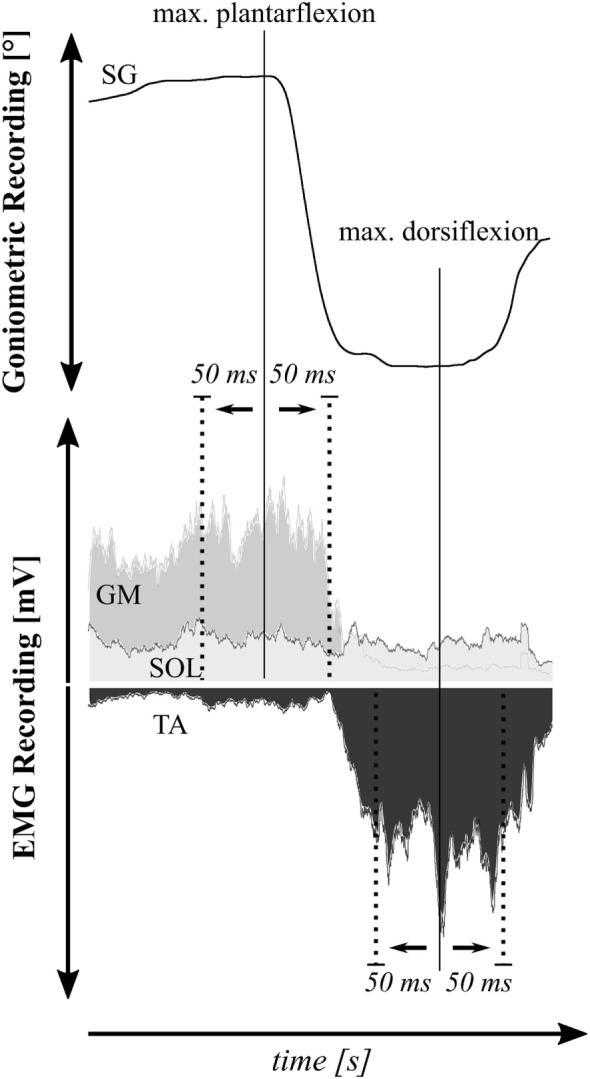
Exemplary illustration of the co-activation ratio determination in the shank: EMG activity of agonists was evaluated in relation to antagonists 50 ms before and 50 ms after peak joint excursion during max. plantarflexion for m. soleus (SOL) EMG and m. gastrocnemius medialis (GM) EMG and during maximal dorsiflexion for m. tibialis anterior (TA) EMG.